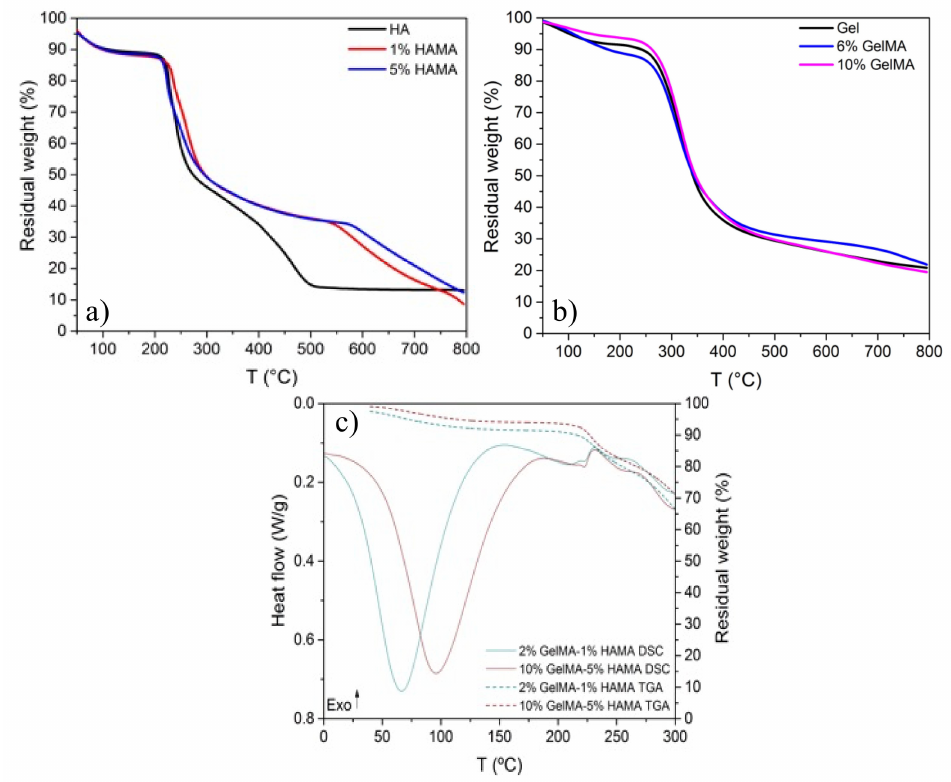
Figure A1. TGA scans of ( a ) pure HA and HAMA and ( b ) pure Gel and GelMA, and ( c ) plots of TGA and DSC runs of hybrid hydrogels with compositions 2% GelMA/1% HAMA and 10% GelMA/5% HAMA for comparison.